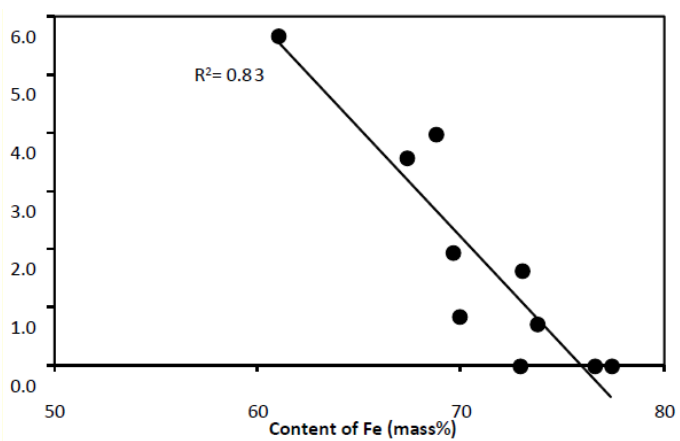
Minerals 2020 , 10 , x FOR PEER REVIEW Figure 5. Di ff erentiation of Fe and Zn content in wustite. Figure 5. Differentiation of Fe and Zn content in wustite. Figure 5. Differentiation of Fe and Zn content in wustite.